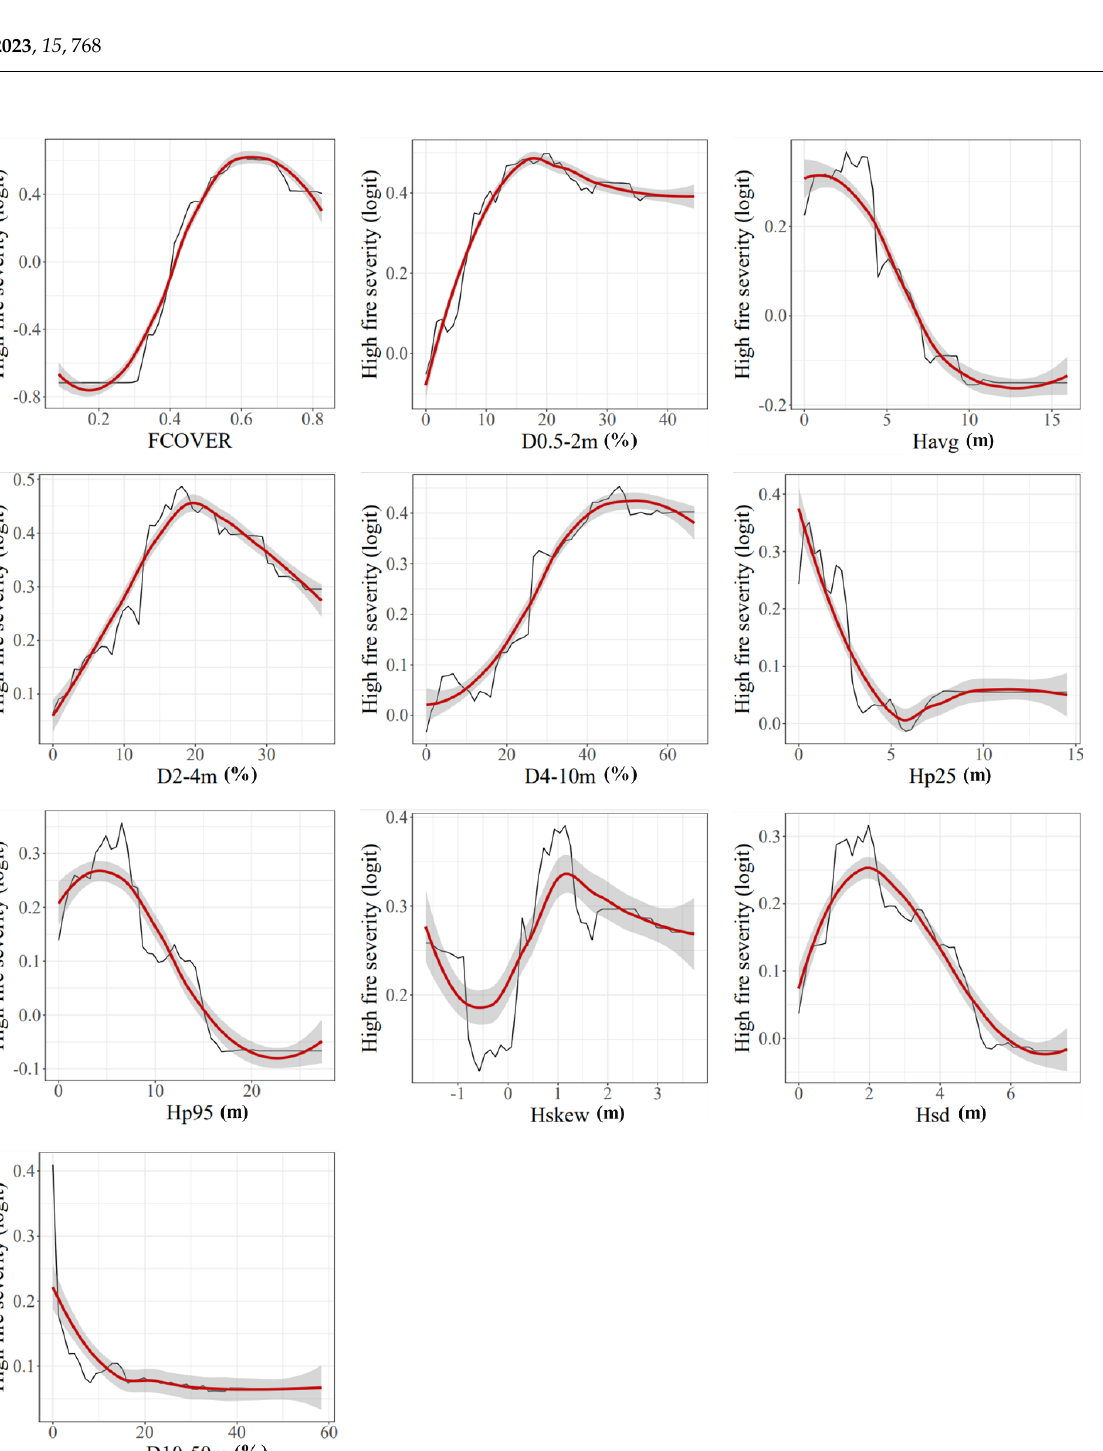
Figure 7. Partial dependence plots of the pre-fire LiDAR metrics in the Random Forests (RF) classi- fication algorithm of fire severity. The probability of high fire severity outcome is displayed in a centered logit scale for each LiDAR metric. The red line is a LOESS smooth curve.